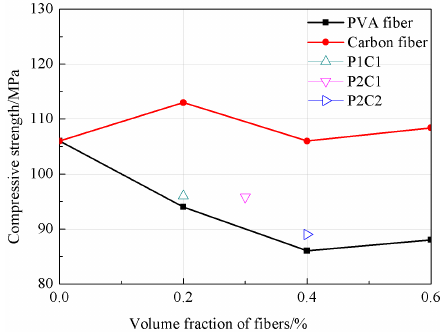
Figure 2. The tendency of the compressive strength.